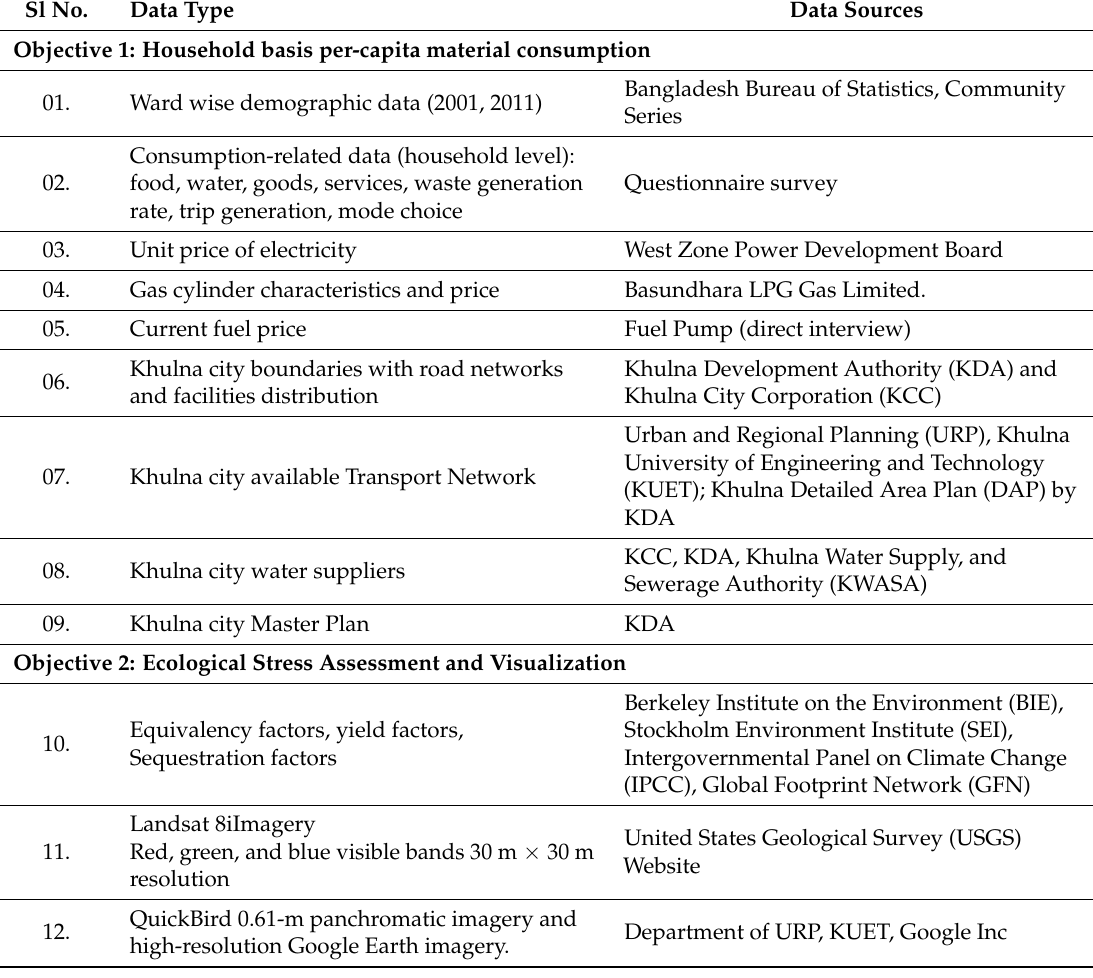
Table 2. Consumption footprint data requirements and data